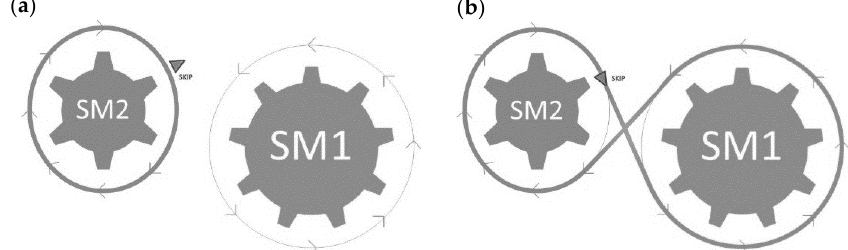
Figure 10. Sequential flow considering compliance or not with the criteria in order to skip from one model to the other: ( a ) Continuous cycle, ( b ) Cycle when “skip” conditions are met. SM1: submodel